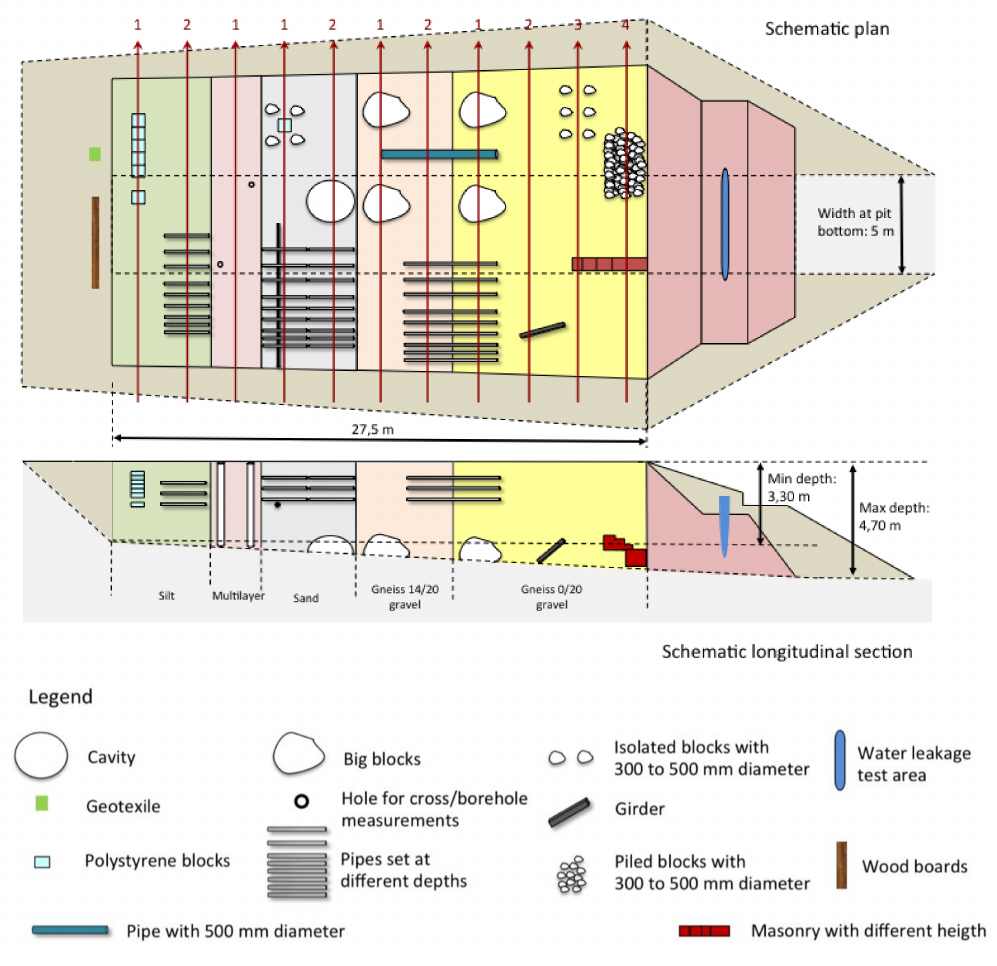
Figure 2. Schematic plan view of the test site and longitudinal section. Red arrows represent the acquisition lines of GPR